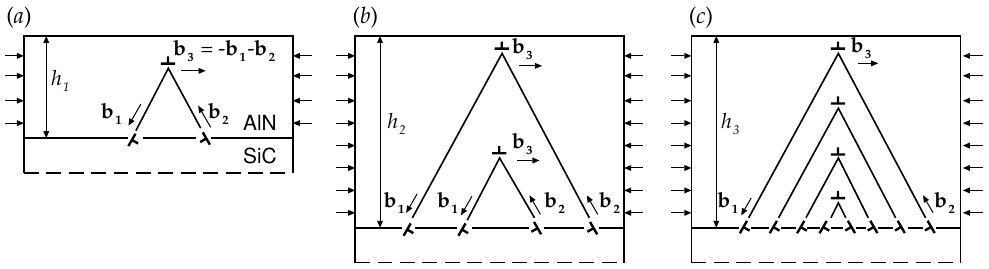
Figure 8. Theoretical model of the formation of a number of Λ -shaped misfit dislocation configurations in the vicinity of the AlN/SiC interface, which produce a vertical wall of b 3 -dislocations (a tilt low-angle boundary) and two horizontal walls of b 1 - and b 2 -dislocations. ( a ) the first Λ -shaped MD configuration generated at h = h 1 > h c as described in Ref. [15]; ( b ) the second Λ -shaped MD configuration generated in a similar way over the first one in the region of extra compression created by the first b 3 -dislocation at h = h 2 > h 1 ; ( c ) a ‘matrioshka’ of a number of Λ -shaped MD configurations repeatedly generated over each other at h = h 3 > h 2